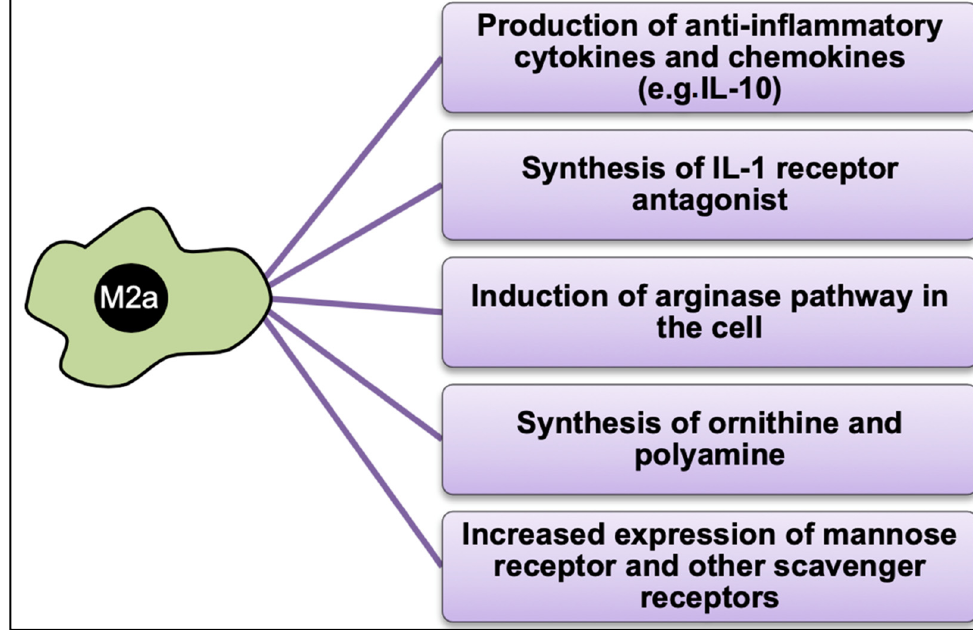
Figure 6. Summary of the function of M2a-macrophages at the cellular level.